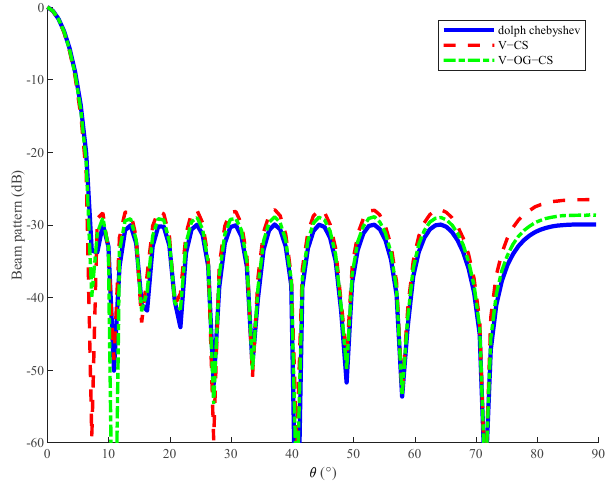
Figure 2. Beam patterns of different methods.